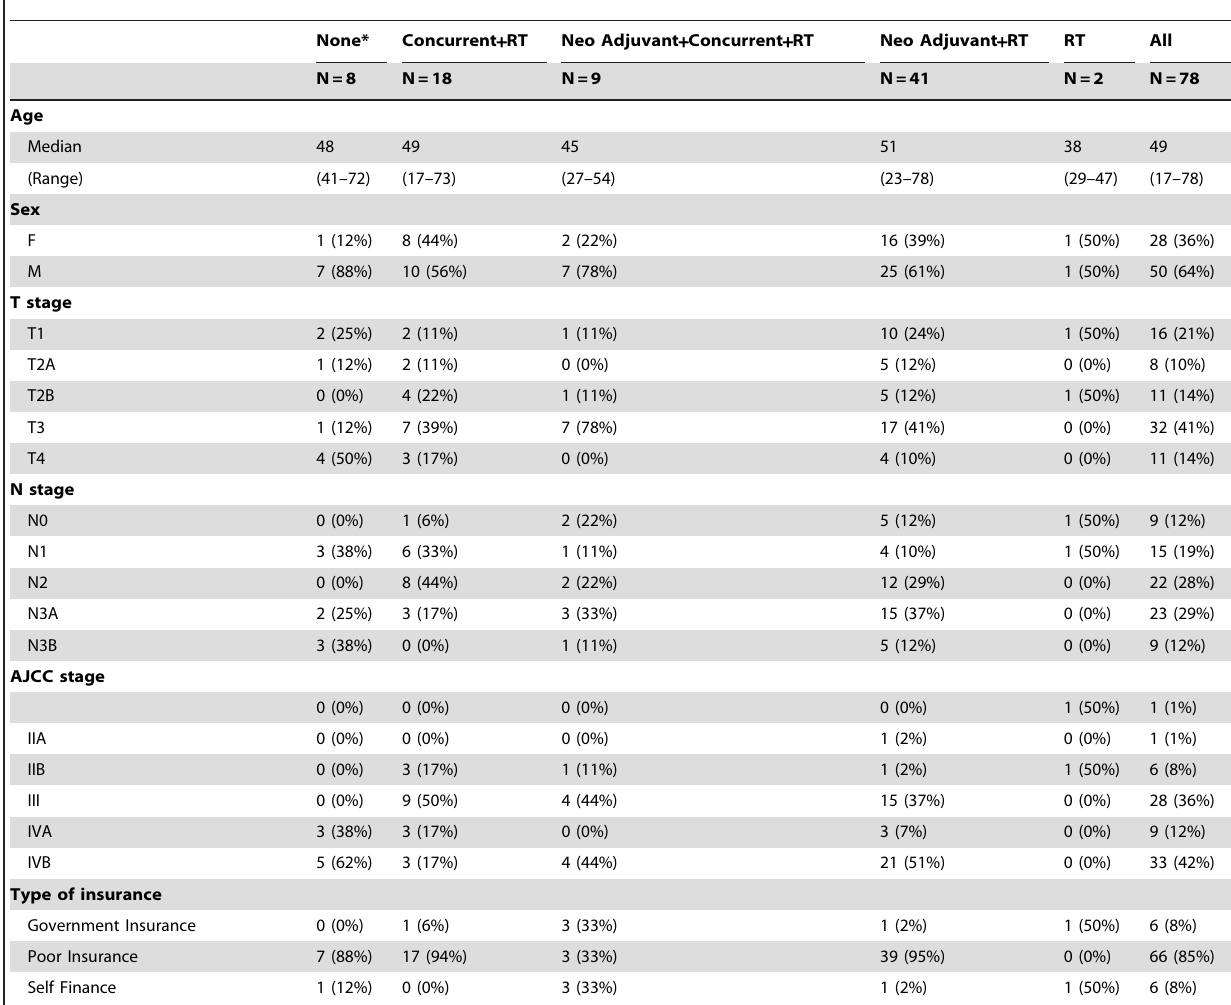
Table 1. Patient characteristics and type of treatment.